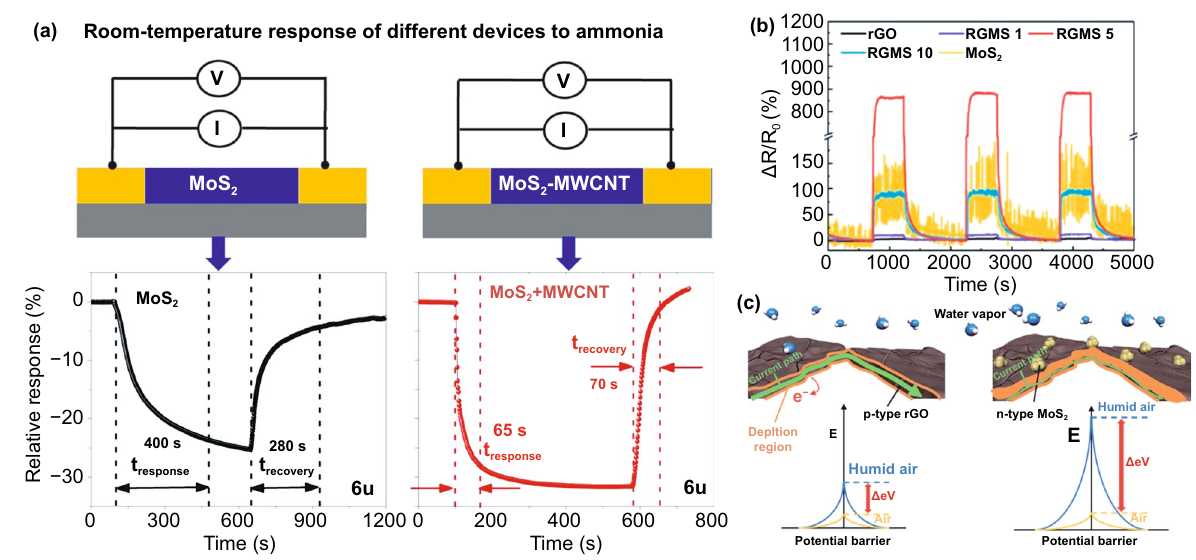
Fig. 17 a NH 3 sensor performance of MoS 2 and MoS 2 /carbon nanotubes composites Reproduced from Ref. [232]. Copyright 2020, Elsevier. b Response curves of rGO, RGMS 1, RGMS 5, RGMS 10, and MoS 2 to 50% RH at room temperature. c Schematic of the mechanism with enhanced humidity sensing properties of the enhanced depletion region on bare rGO and RGMS. Reproduced from Ref. [233]. Copyright 2018, The Royal Society of